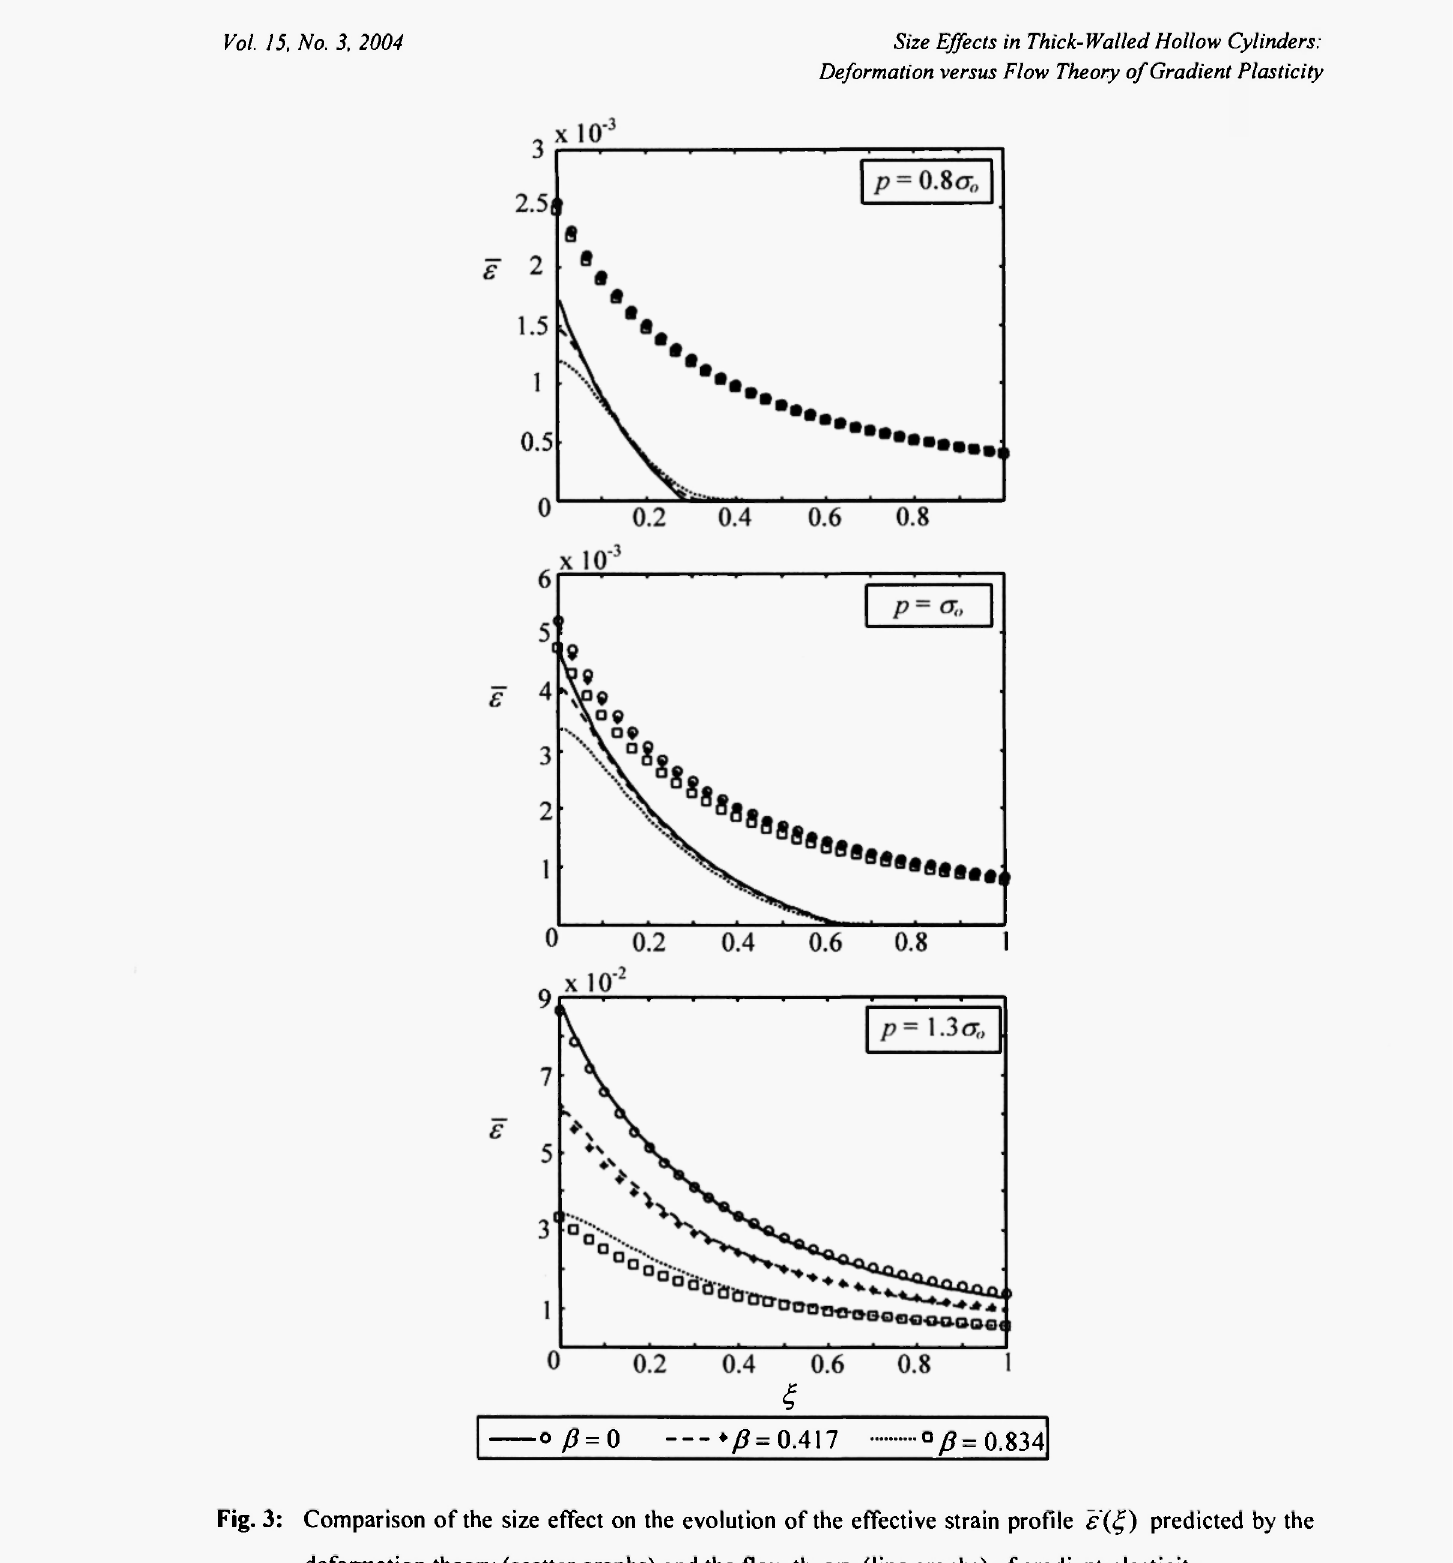
Fig. 3: Comparison of the size effect on the evolution of the effective strain profile ε (ξ) predicted by the deformation theory (scatter graphs) and the flow theory (line graphs) of gradient